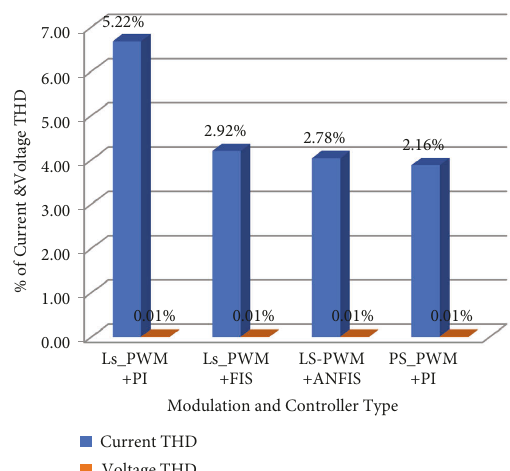
Figure 20: Overall current and voltage THD of controllers with modulations.